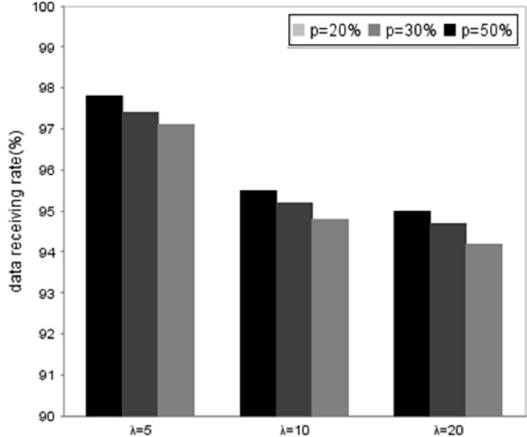
Figure 9. Comparison of data receiving rate generate in different traffic flow and p .